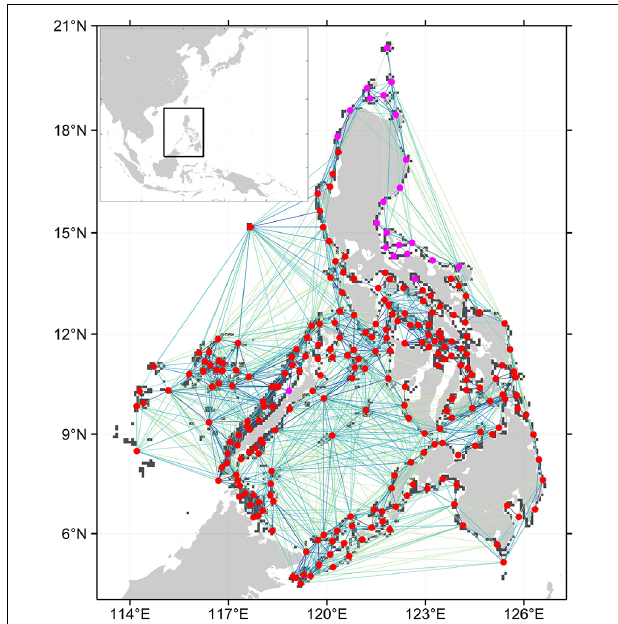
FIGURE 1 | Connectivity network for branching coral. Only the top 50% of connections are shown, darker lines are stronger connections. Circles represent the centroids of the 252 reef nodes within the Philippine EEZ. Red circles are nodes that are part of the largest strongly connected component (SCC) when the weakest 50% of connections are removed. Purple circles are nodes that are unidirectionally connected to the main